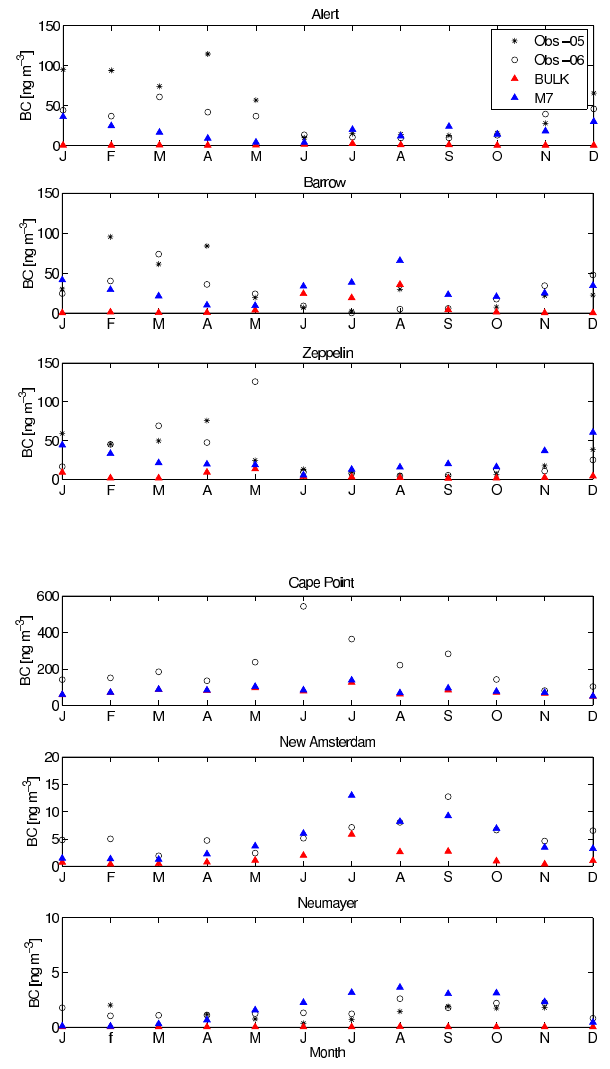
Fig. 4. Monthly mean modelled (year 2005/2006) BC surface con- centrations [ngm − 3 ] with BULK and M7 and measured (year 2005 and/or 2006) BC concentration at Alert, Barrow, Zeppelin, Cape Point, Amsterdam Island and Neumayer (Antarctica). Note that measurements are equivalent black carbon